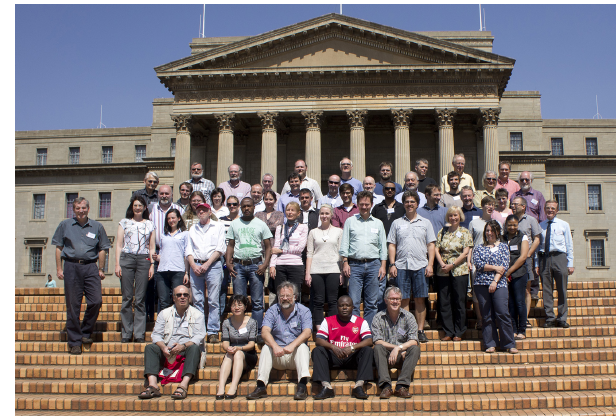
Figure 2. Bushveld workshop participants pose in front of the Great Hall at Wits